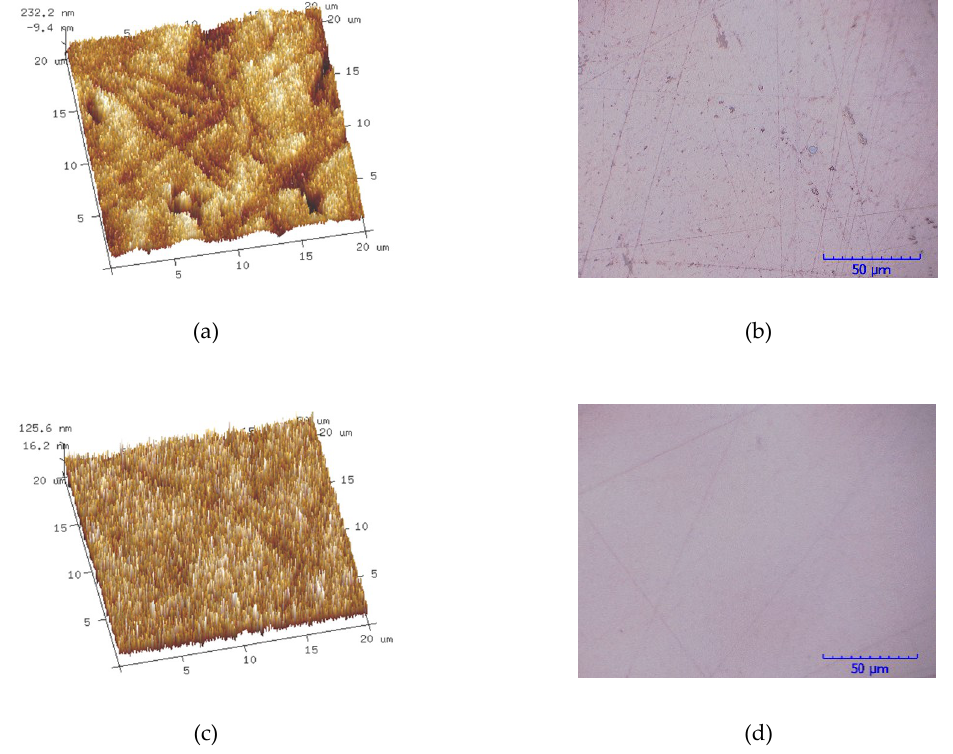
Figure 13. Ra and surface macro-morphology of X-cut and Z-cut. ( a ) Ra of X-cut (Ra 64 nm); ( b ) surface morphology of X-cut; ( c ) Ra of Z-cut (Ra 35 nm); ( d ) surface morphology of Z-cut.